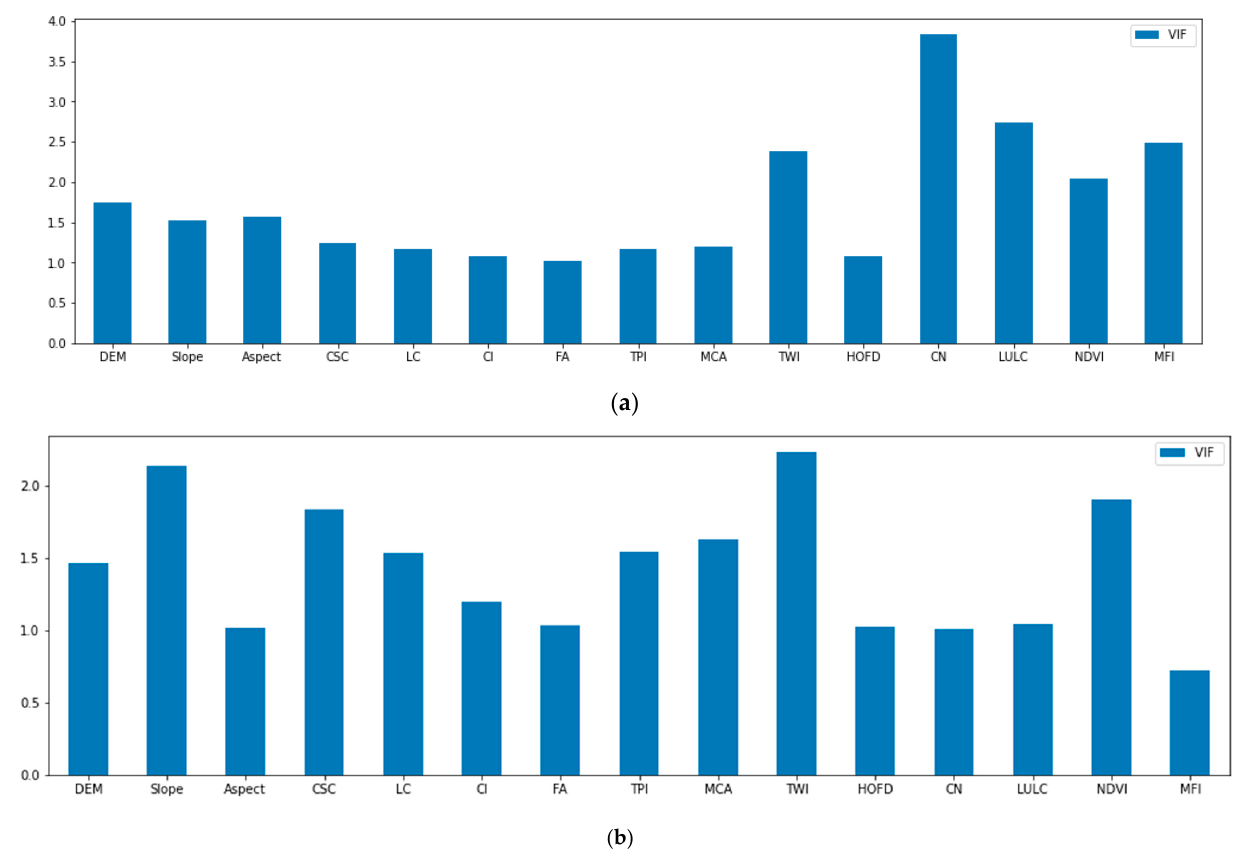
Figure 7. Variance Inflation Factor (VIF) of all variables. ( a ) Karun Basin, and ( b ) Gorganrud Basin.